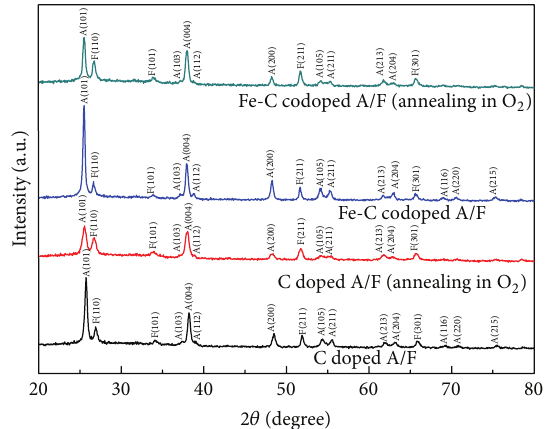
Figure 1: XRD patterns of the C doped A/F films, C doped A/F films (annealed in O 2 ), Fe-C codoped A/F films, and Fe-C codoped A/F films (annealed in O 2 ) on FTO substrates (A/F; A: anatase; F: ITO).